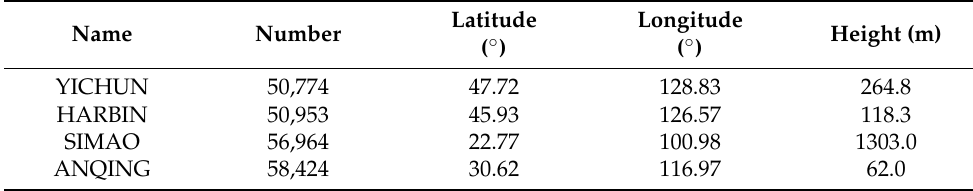
Figure 4. Monthly slope coefficient of the T m - T s model from 2011 to 2019.